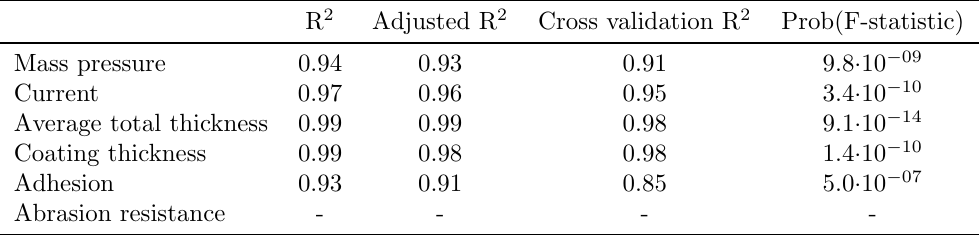
Table 3: Statistical model properties